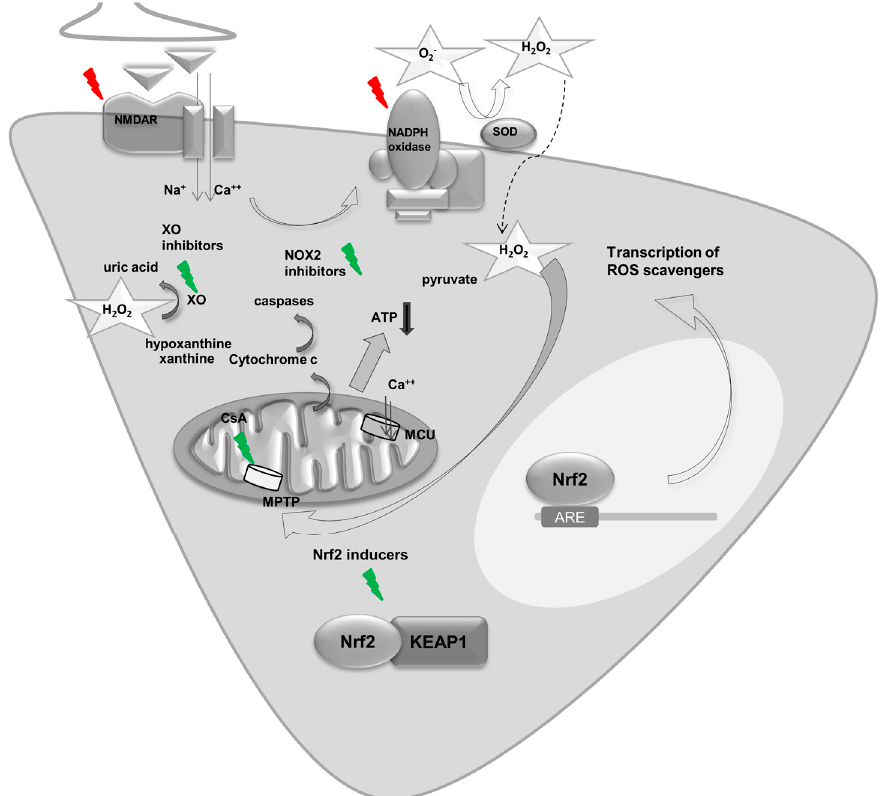
Figure 3. Metabolic and homeostatic changes during seizures and epilepsy. Metabolic and homeostatic changes during seizures and epilepsy and pathways that can be targeted to ameliorate these [96]; NMDA-R: NMDA-Receptor; SOD: superoxide dismutase; ARE: Antioxidant Response element; MCU: mitochondrial Ca 2+ uniporter; MPTP: mitochondrial permeability transition pore, O 2- : superoxide. KEAP1: Kelch-like ECH-associated protein 1; XO: xanthine oxidase. The red flashes indicate processes which lead to cell death during seizure activity whereas the green flashes represent interventions and targets which reduce cell death during seizure activity.